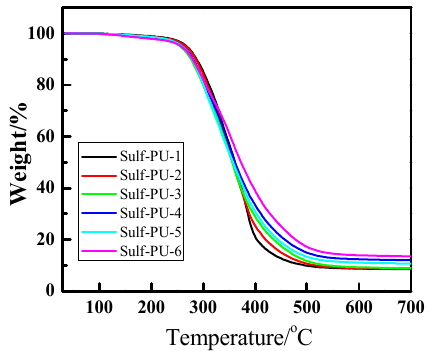
Figure 2. Thermogravimetric analysis (TGA) curves of the coatings prepared with various of sulf- PUs.